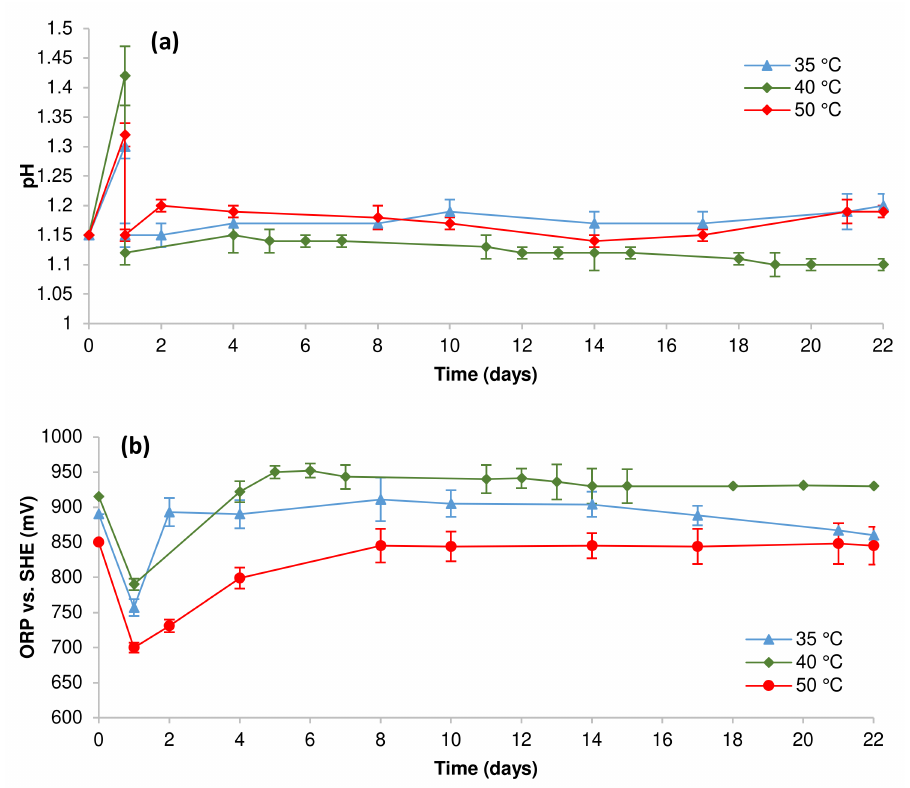
Figure 1. Values of ( a ) pH and ( b ) redox potential during stirred-tank bioleaching (pulp density, 1 wt%). Table 3. Content of main minerals in the bioleach residues (pulp density, 1 wt%; duration, 22 days). Temperature at Bioleaching ( ◦